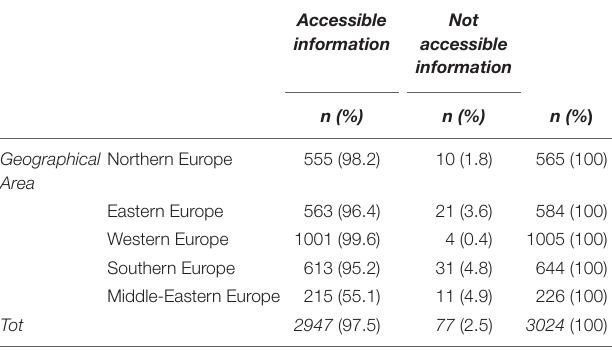
TABLE 3 | Online data available for every institutions in different European geographical